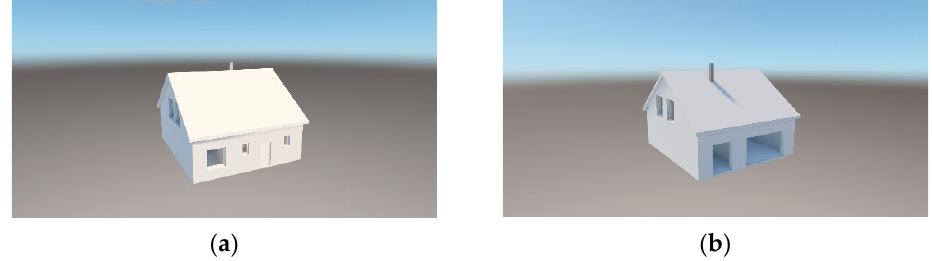
Figure 5. The general visualization of the analyzed building: ( a ) north façade, ( b ) south